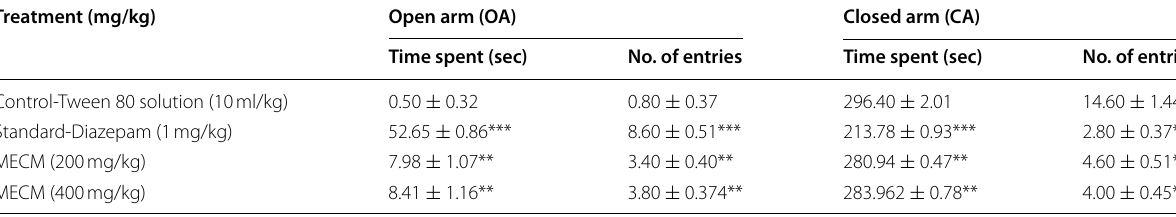
MECM Methanolic extract of seeds, SEM standard error of the mean All values are expressed as Mean ** p < 0.01, *** p < 0.001 were considered statistically significant compared to control